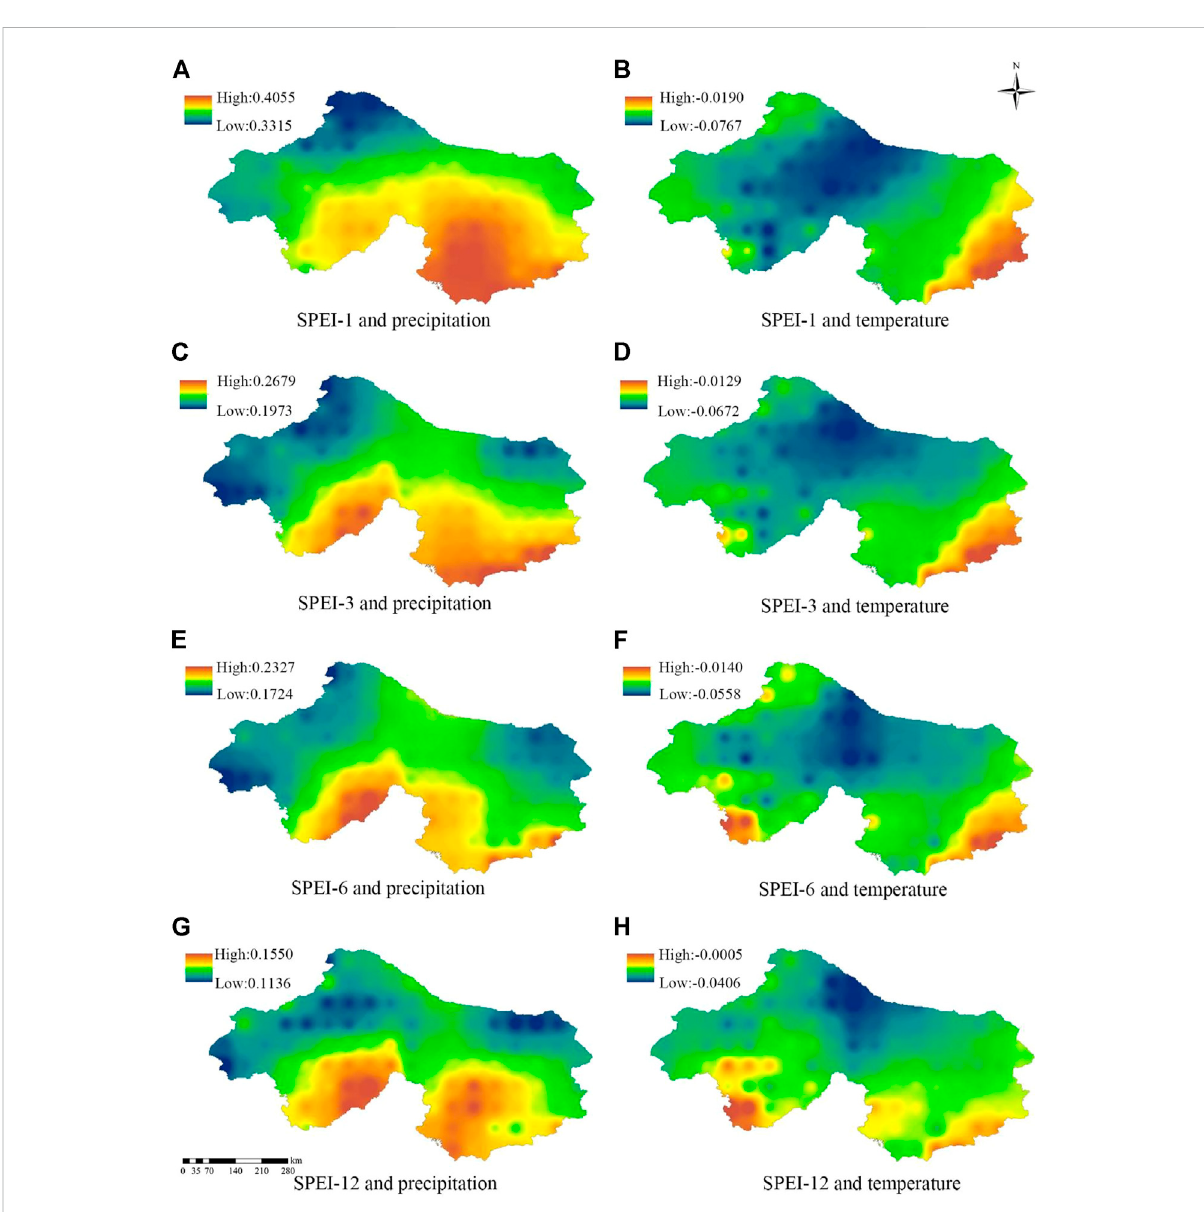
FIGURE 7 SpatialdistributionofthePearsonscorrelationbetweenSPEIandprecipitationandairtemperatureatdifferenttimescalesfrom1961to2018. (A, C, E, G) are the Pearson correlations betweenSPEI-1, SPEI-3, SPEI-6, SPEI-12 and precipitation respectively; (B, D, F, H) are the Pearson correlations between SPEI-1, SPEI-3, SPEI-6, SPEI-12 and temperature